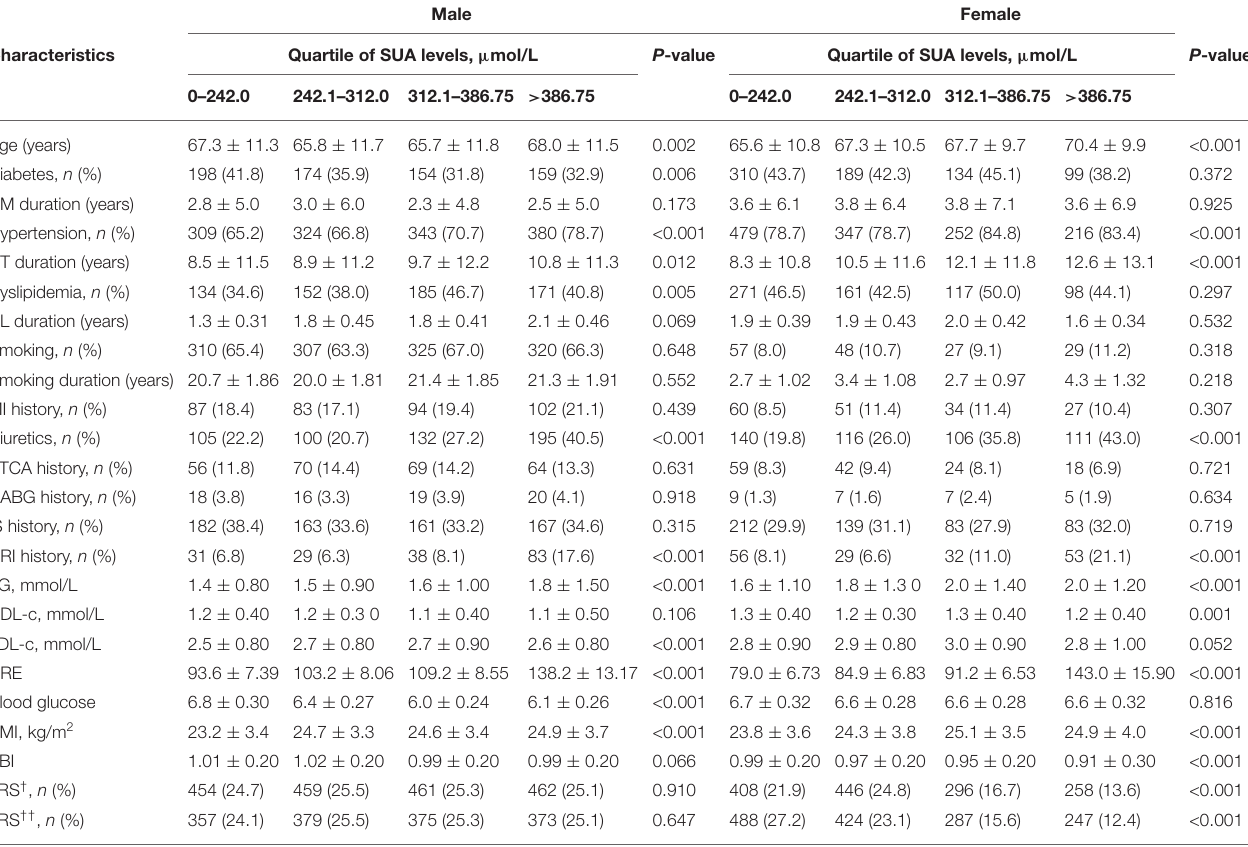
TABLE 1 | Comparison of subjects’ baseline characteristics of sex categories according to serum uric acid level. Male